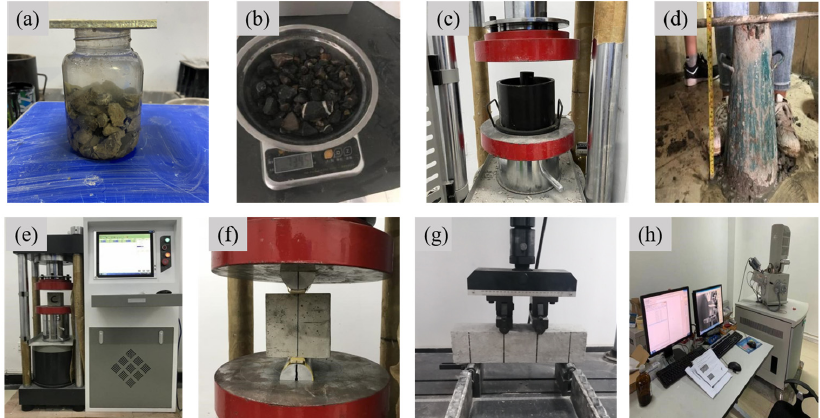
Figure 5. Testing and equipment: ( a ) apparent density; ( b ) water absorption; ( c ) crushing index; ( d ) slump; ( e ) compressive strength; ( f ) splitting tensile strength; ( g ) flexural strength; and ( h ) scanning electron